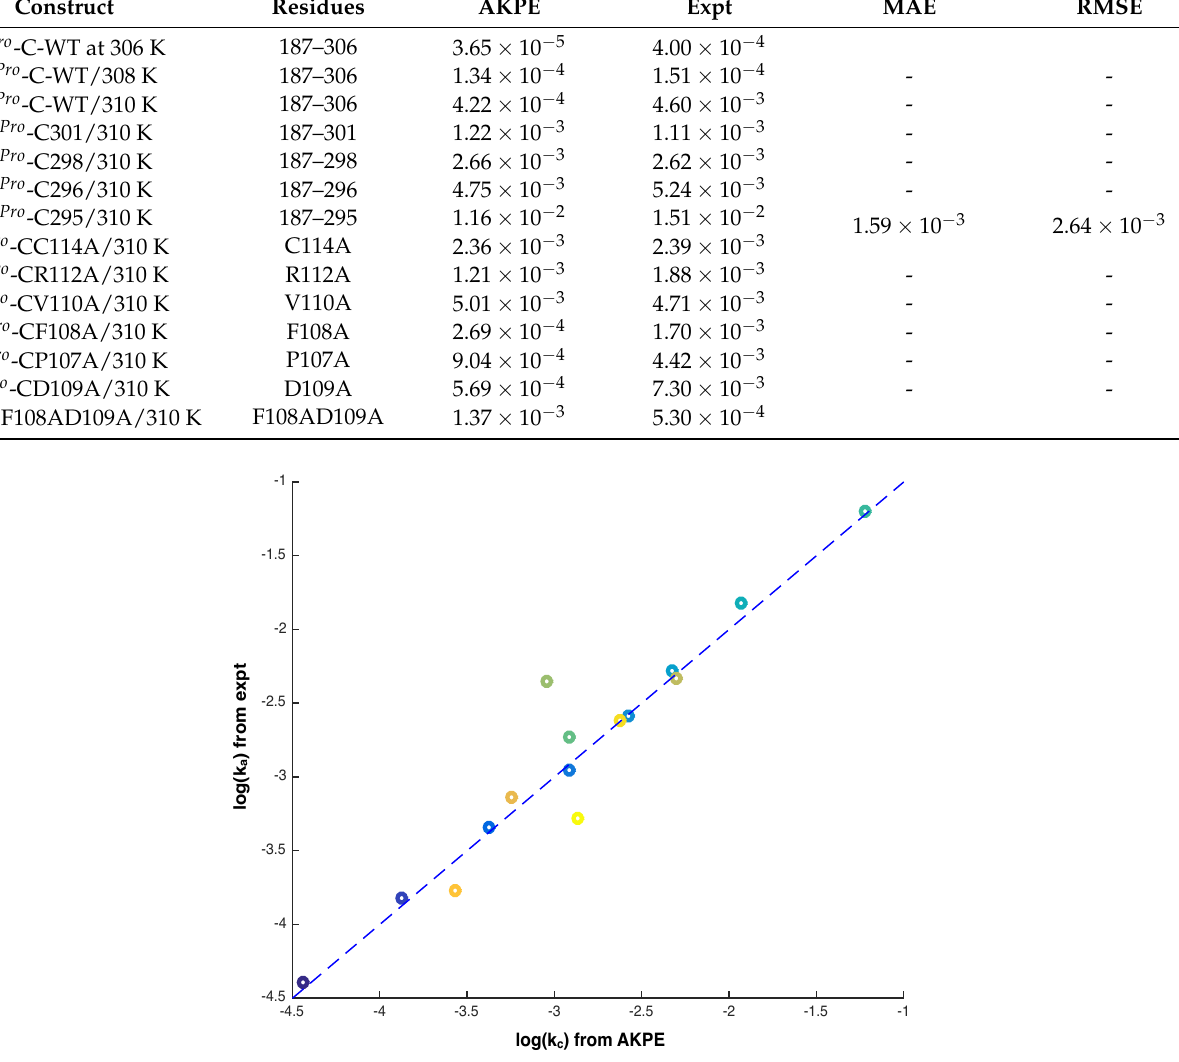
Figure 9. Comparison between the predicted association constant k c produced by AKPE and experi- mentally measured association constant k a , agreement between the two can be a ll